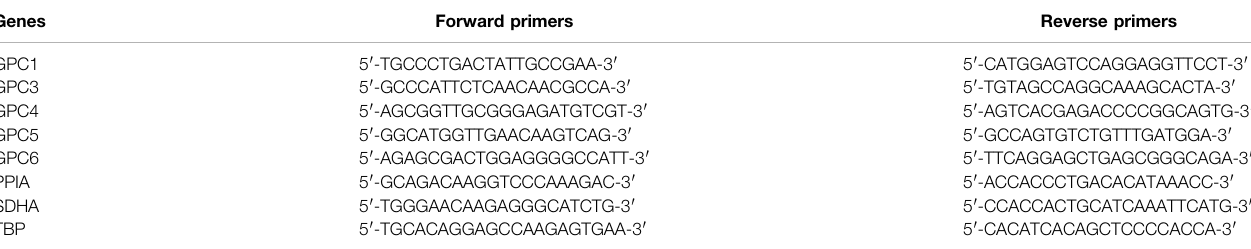
TABLE 2 | Primers used for real-time RT-PCR.